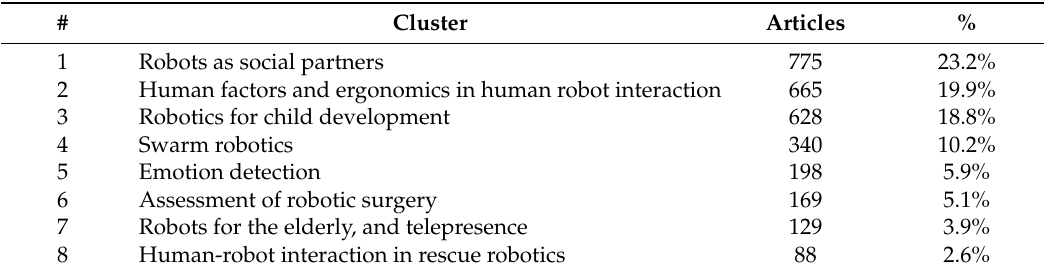
Table 2. Clusters in the social robotics network.